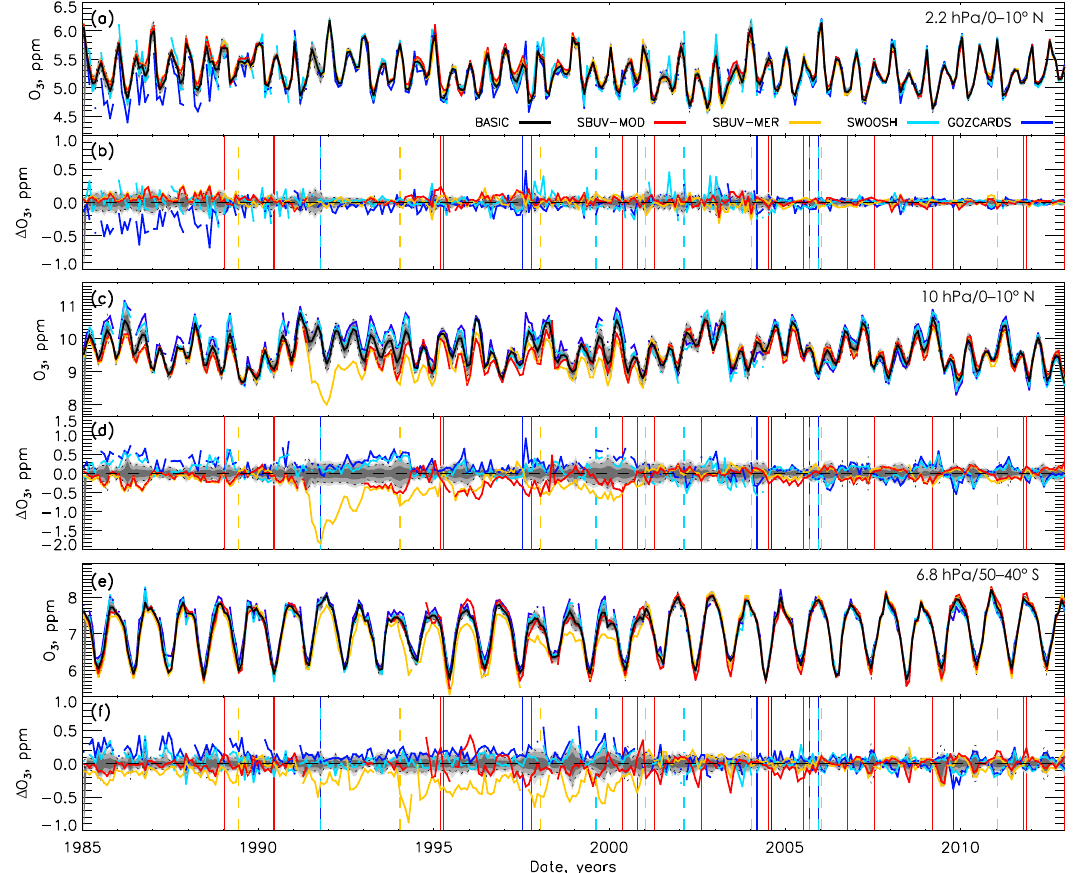
Figure 6. Ozone time series at three stratospheric locations from 1985 to 2012, all bias shifted to the mean of SWOOSH after August 2005. (a) Absolute ozone at 2.2hPa over 0–10 ◦ N from SWOOSH (light blue), GOZCARDS (blue), SBUV-MER (yellow), and SBUV-MOD (red). The BASIC composite mean estimation (black) is plotted with shading representing 68% (dark grey), 95% (grey), and 99% (light grey) credible intervals (CIs); these CIs are not Gaussian, so 2 times the standard deviation is also plotted with thin dotted lines. Panel (b) is the same as (a) , but now for the difference relative to the BASIC composite. Panels (c) and (d) are as the same as (a) and (b) at 10hPa and 0–10 ◦ N, and (e) and (f) are the same as (a) and (b) at 6.8hPa and 50–40 ◦ S. Vertical dashed and solid lines in panels (b) , (d) , and (f) identify changes in the instruments used in the